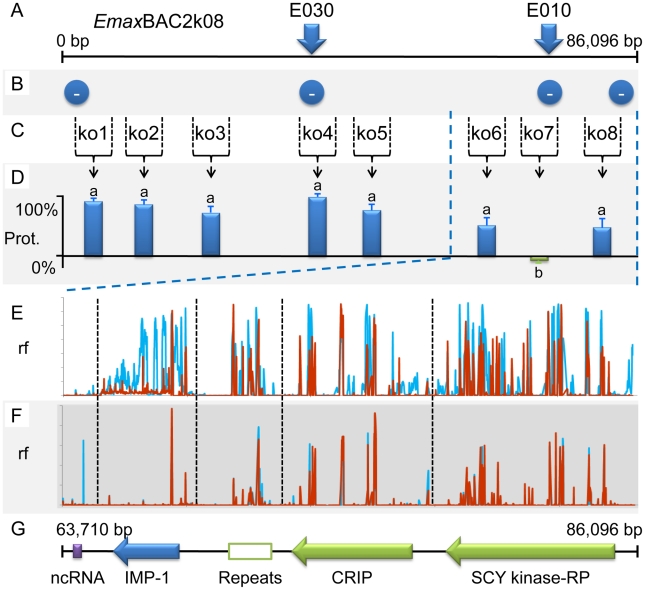
Fine mapping locus 5 correlated with susceptibility to strain-specific immune killing.(A) The distribution of strain-specific AFLP markers lost under immune selection across BAC EmaxBAC2k08. (B) Recovery of strain-specific markers by immune selected backcross generations revealed that the entire BAC encoded-region remained absent in all generations (−). (C) Regions 1–8 selected for disruption by BAC recombineering. (D) The influence of targeted disruption on the ability of W strain-derived EmaxBAC2k08 to confer cross-protective immunity when delivered by the heterologous Eimeria maxima H strain following transient transfection: the protective capacity retained by each recombineered BAC compared to the unmodified parent BAC. Bars marked with different letters were significantly different (p<0.05). (E–F) Relative fluorescence (rf) illustrating cDNA hybridisation to a BAC-tiling NimbleGen array covering ∼22.4 Kb of locus 5 corresponding to the smaller Not I/Sfi I BAC digest product. (E) cDNA derived from sporozoite (blue) and merozoite (67 hpi; red) lifecycle stages. (F) Profiles calculated from rf using cDNA derived from uninfected chicken intestinal tissue subtracted from chicken intestinal tissue 6 (blue) and 16 (red) hours post infection. (G) Transcribed sequences identified within locus 5 (repeats = a repetitive region, no evidence of transcription by targeted lifecycle stages, CRIP = putative cyclophilin-RNA interacting protein, RP = related protein.